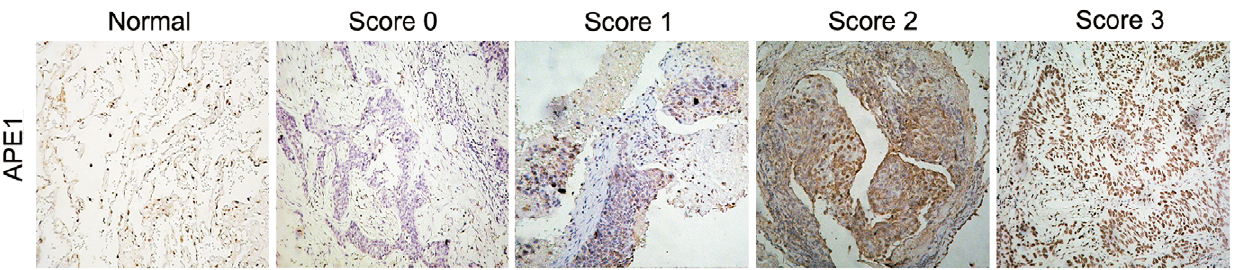
Figure 4. APE1 protein expression in NSCLC tissues. Representative APE1 immunostaining of NSCLC tissues. APE1 staining was observed three subcellular locations in tumor tissues: the nucleus, the cytoplasm and both in nucleus and cytoplasm. Samples were scored as follows: 0, absence or positive cell percentage less than 25%; 1, positive cell percentage between 25% and 50%; 2, positive cell percentage between 50% and 75%; 3, positive cell percentage more than75%.